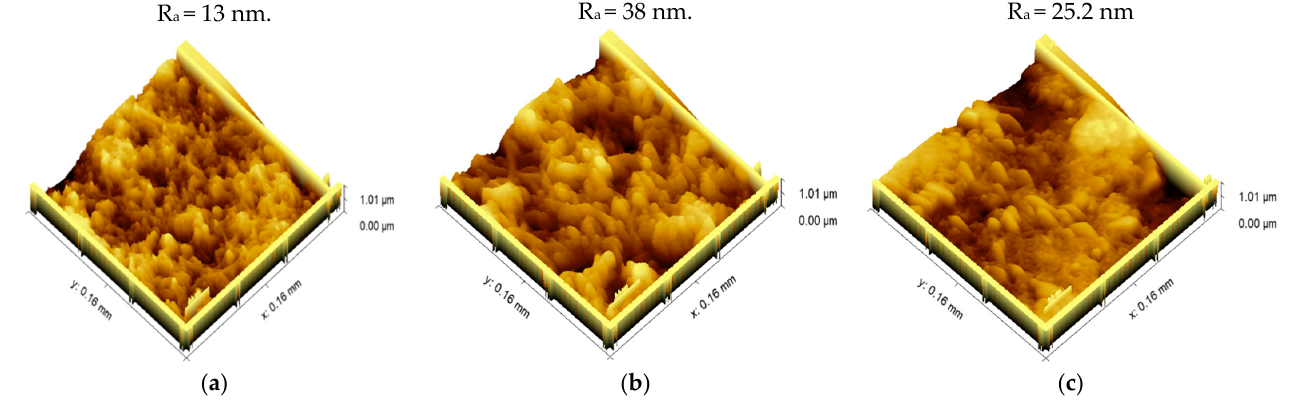
Figure 5. The contact angle test for ( a ) bare MWCNT/AuNPs and ( b ) targeted electrode PSA/MCH/aptamer/MWCNT/AuNP. R a = 13 nm.